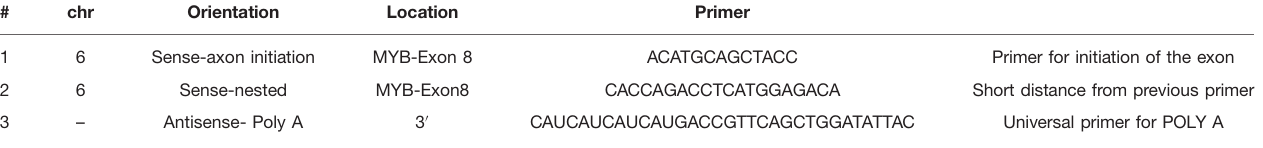
TABLE 6 | List of primers for